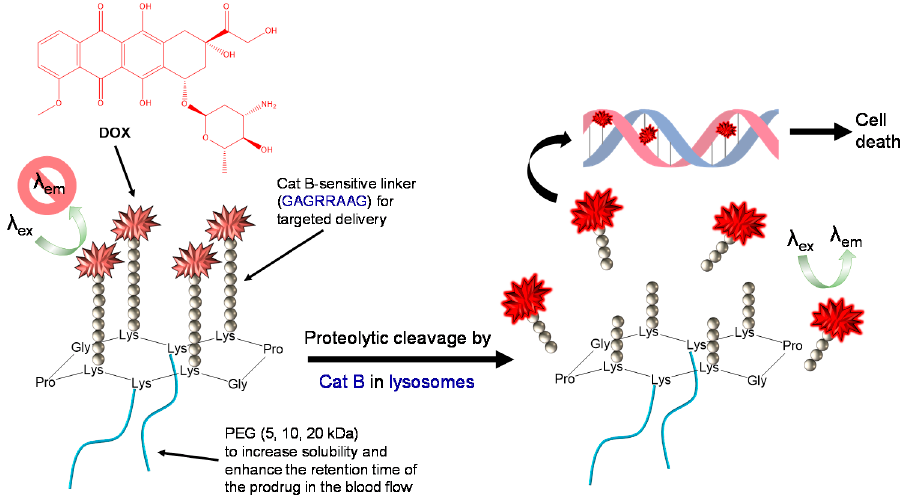
Figure 1. Schematic representation of a cyclopeptidic chemotherapeutic prodrug (cPCP) and its action.